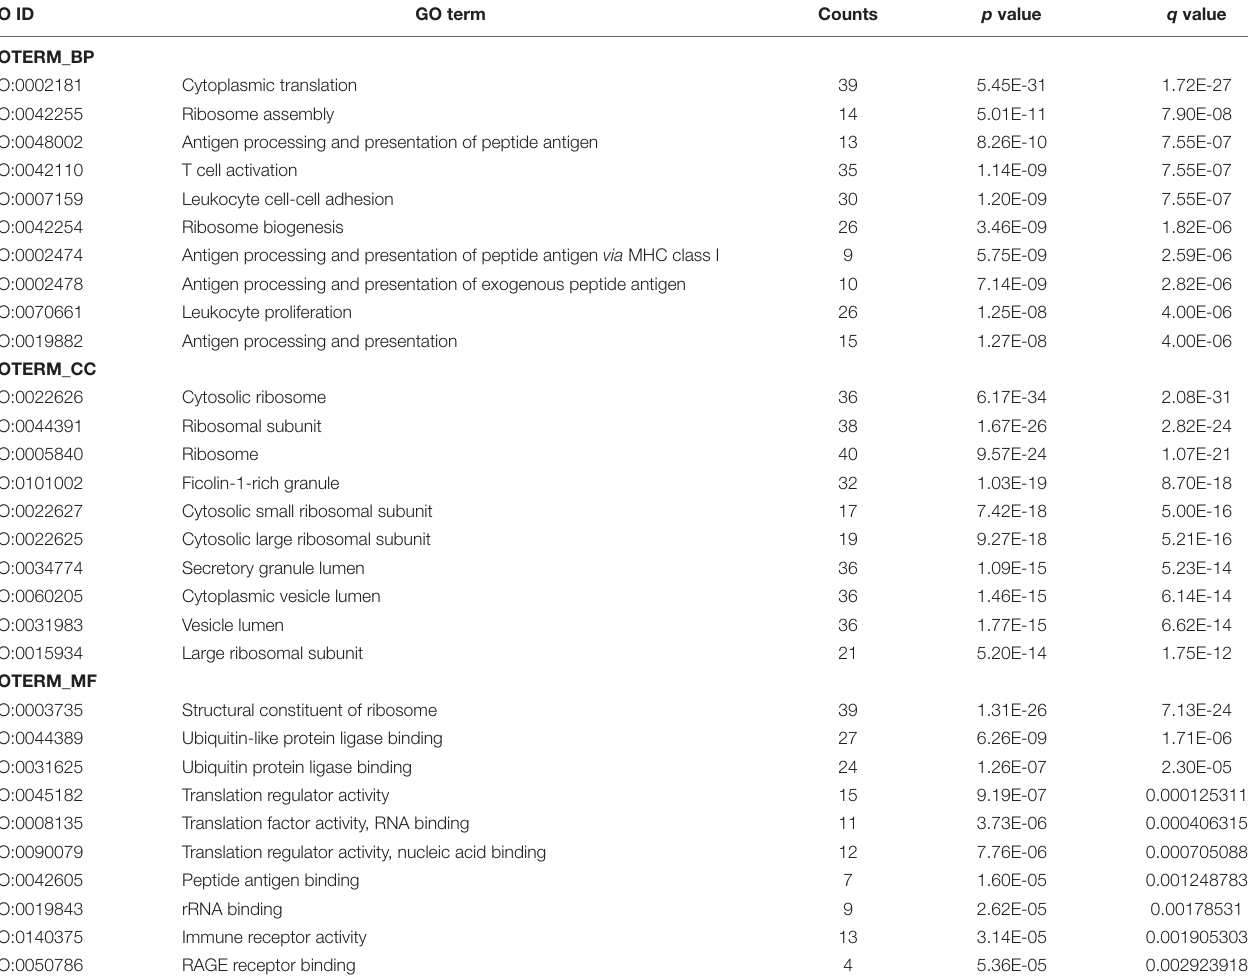
TABLE 2 | The Gene Ontology (GO) terms for the